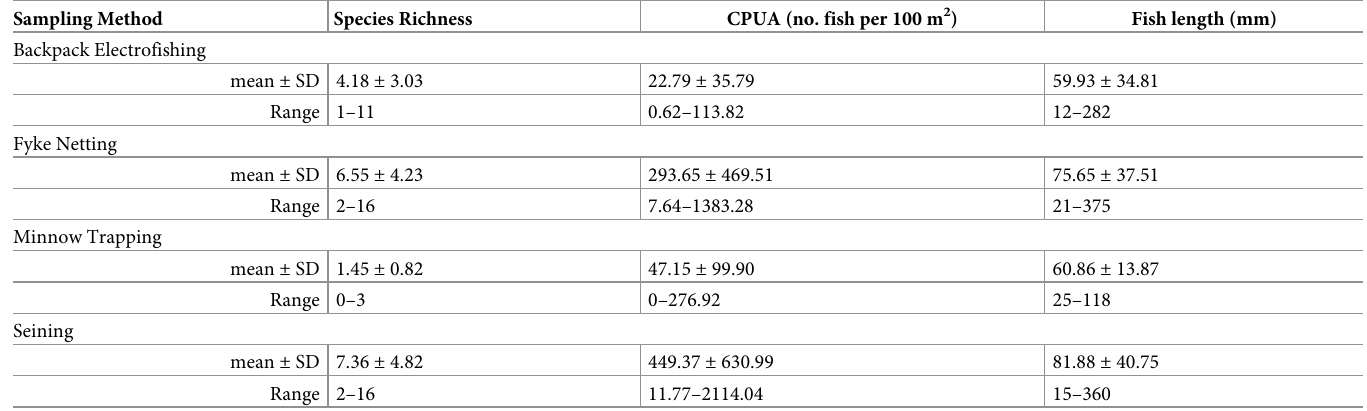
Table 1. Descriptive statistics by sampling method for each quantitative metric. Sampling